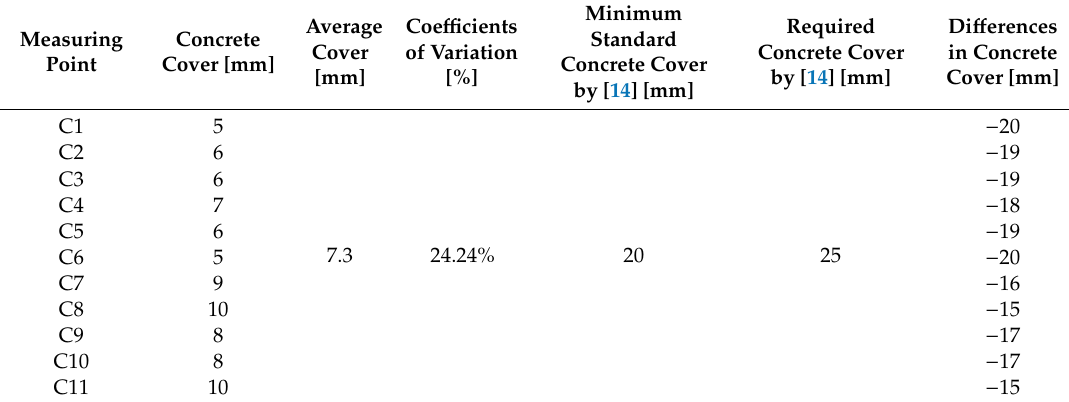
Table 4. Determined and standard values of concrete